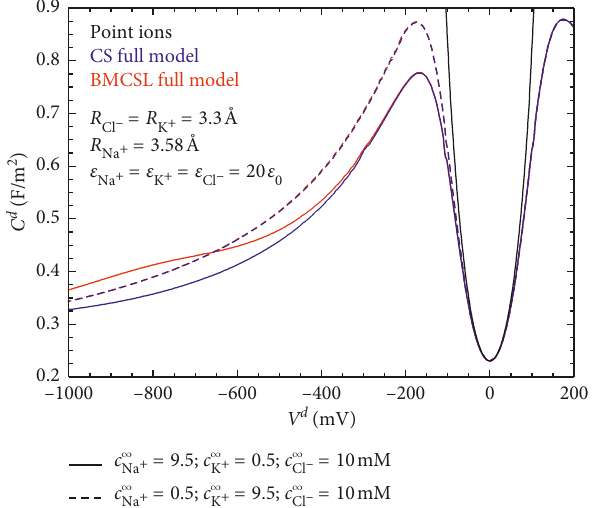
Figure 10: Dependence of the differential capacitance of the diffuse electric double layer on the potential drop across this layer cal- culated using the CS and BMCSL full models and mixed aqueous NaCl and KCl solutions with the indicated parameters.